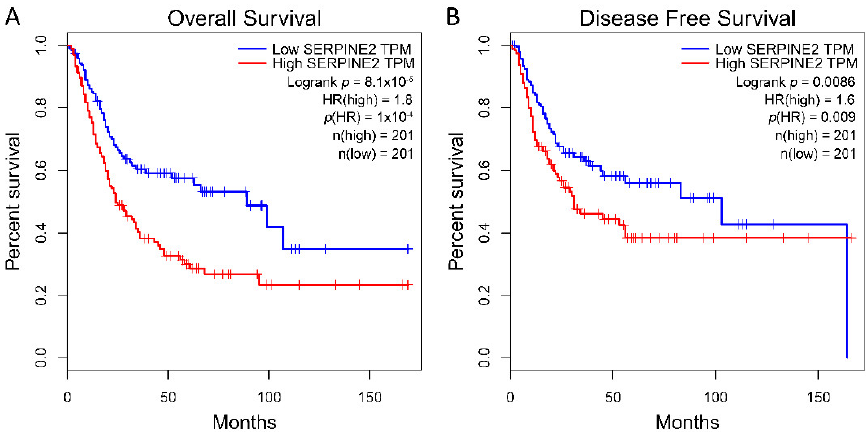
Figure 1. Survival analysis using TCGA database plotted using Kaplan–Meier curves. The overall survival ( A ) and disease-free survival ( B ) curves comparing patients with high (red) and low (blue) SERPINE2 mRNA expressions were plotted. The log-rank test showed that high SERPINE2 mRNA expression predicted poor overall and disease-free survivals in bladder